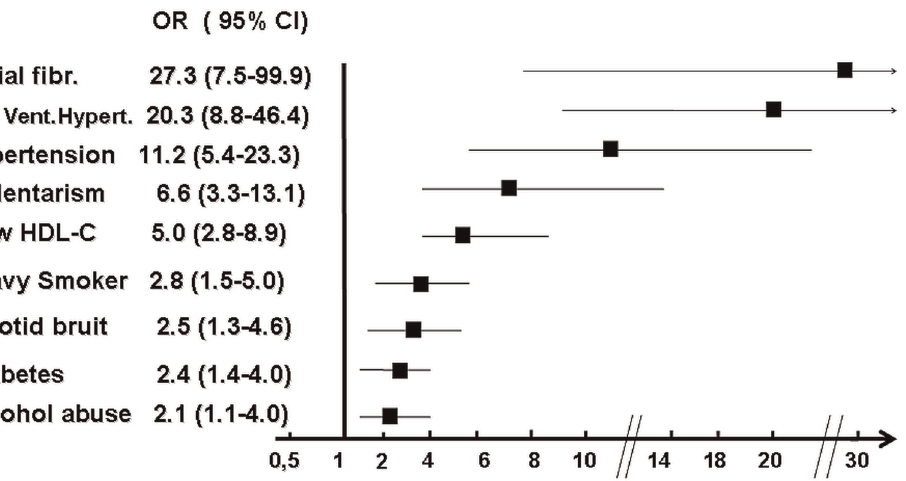
Figure 1. Odds ratios (95% CI) for ischemic stroke: results of a logistic regression adjusting for hypertension, diabetes and smoking status.